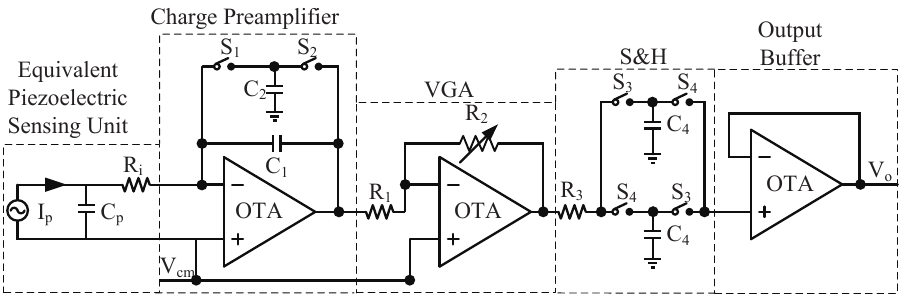
Figure 2. Proposed architecture of the analog front end